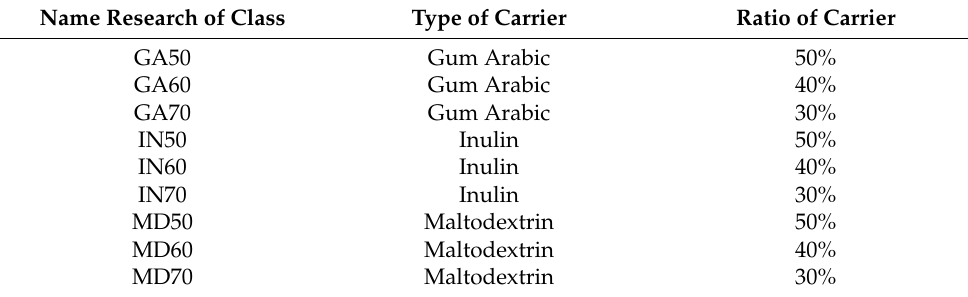
Table 1. Names of experimental variants used in the research